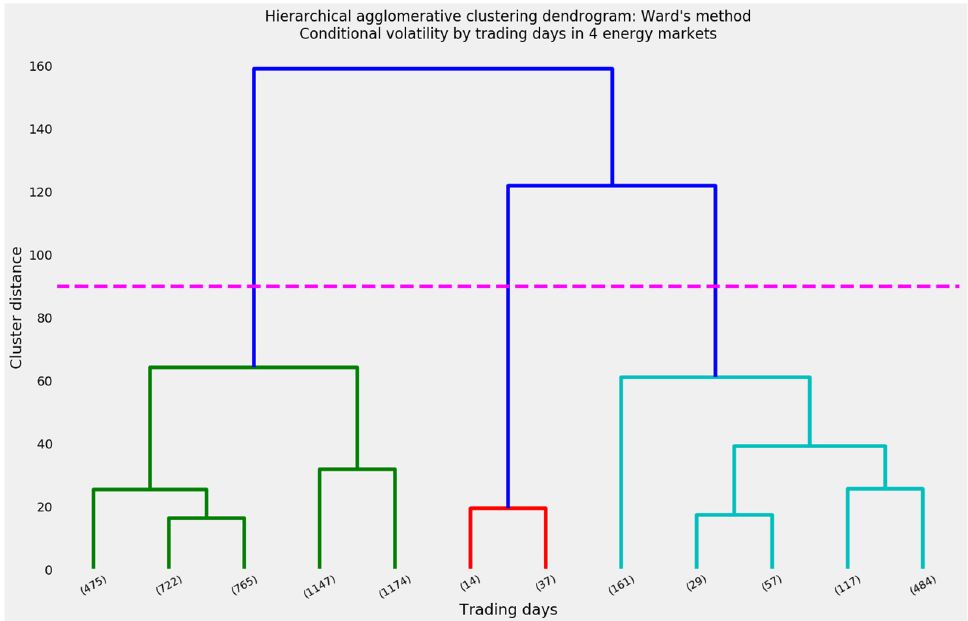
Figure 23. Hierarchical agglomerative clustering of energy-related markets—A dendrogram trun- cated at 12 clusters, with a horizonal cut indicating three clusters.